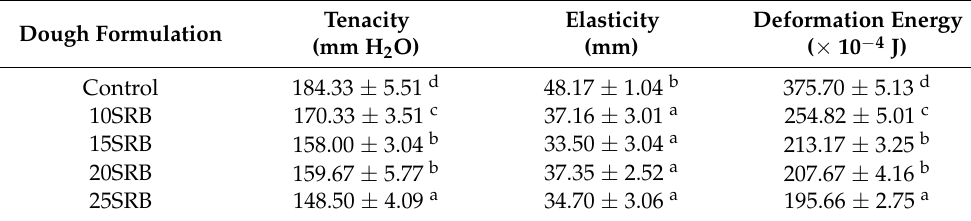
Table 3. Extension properties of control and experimental doughs formulated with different levels of SRB substitution. Dough Formulation